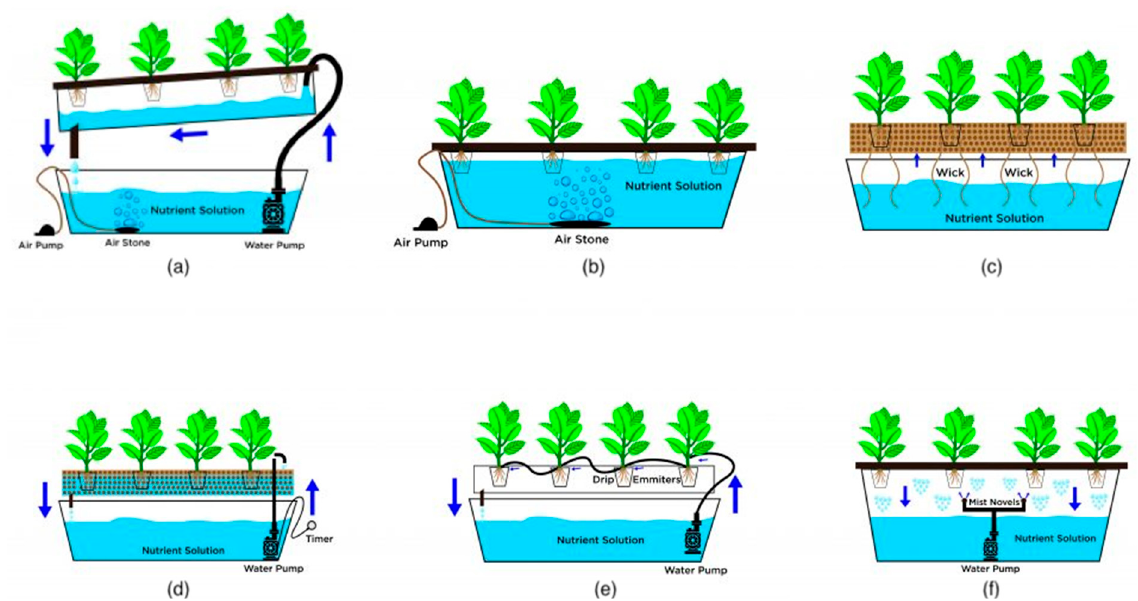
Figure 2. Different hydroponic system techniques: nutrient film technique (NFT) ( a ); deep water culture (DWC) ( b ); wick system ( c ); ebb and flood system ( d ); drip system ( e ); aeroponic system ( f ). Adapted from [44] .